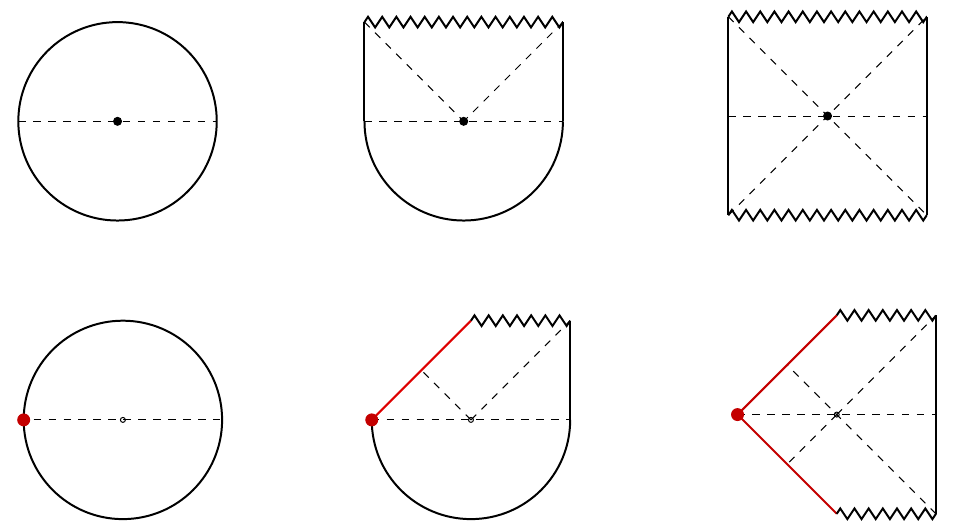
Figure 1 . The euclidean (left), lorentzian (right) space-time associated with the thermo-(cid:12)eld double state (top) and thermal pure state (bottom). The middle column shows the total geometry describing the state preparation and real time evolution, obtained by gluing the euclidean and lorentzian geometry together along the equator of the